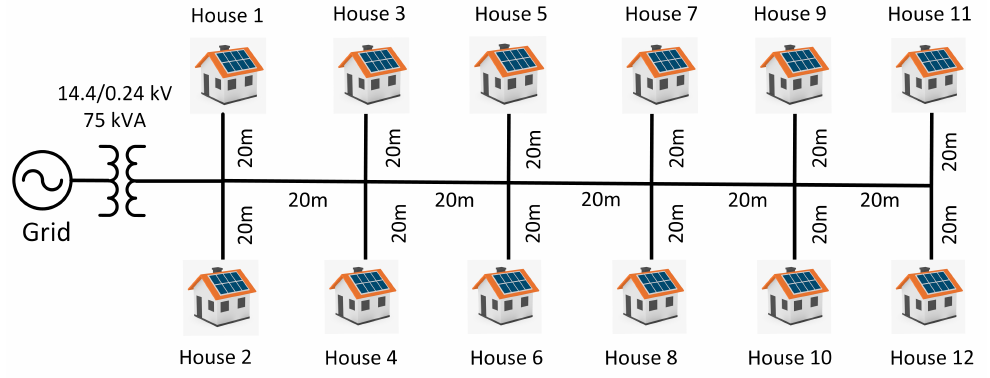
Figure 5. Benchmark of the suburban residential voltage distribution